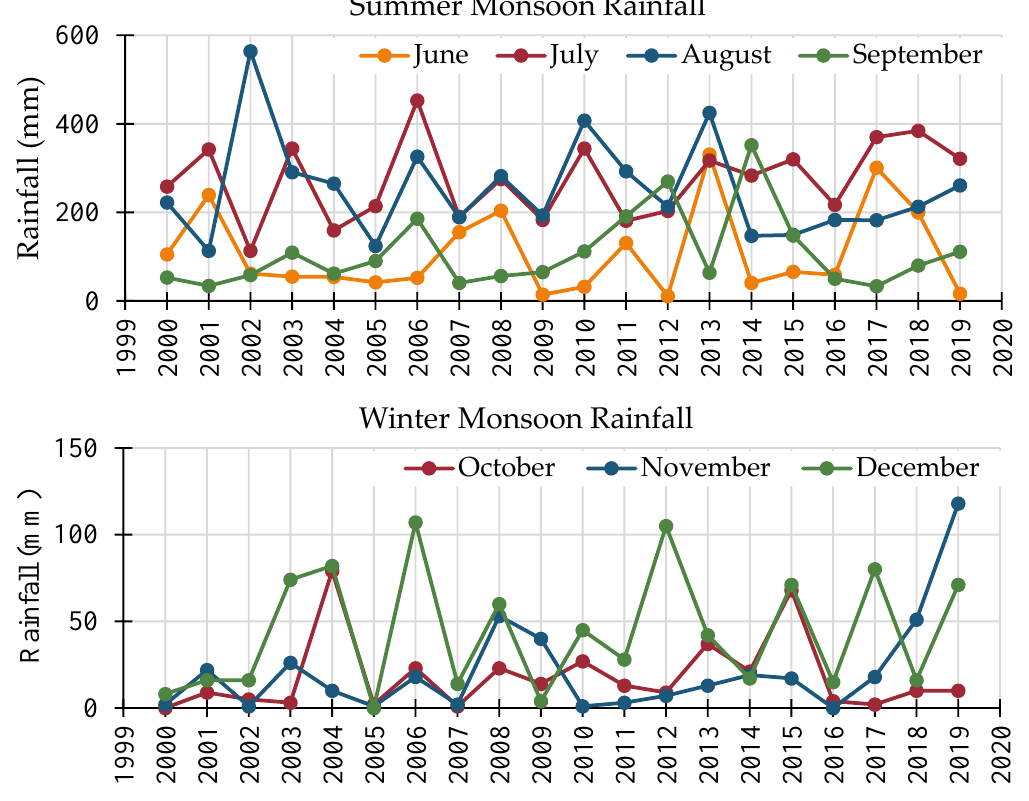
Figure 13. Mean monthly rainfall in mm for the months of summer and winter monsoon seasons.